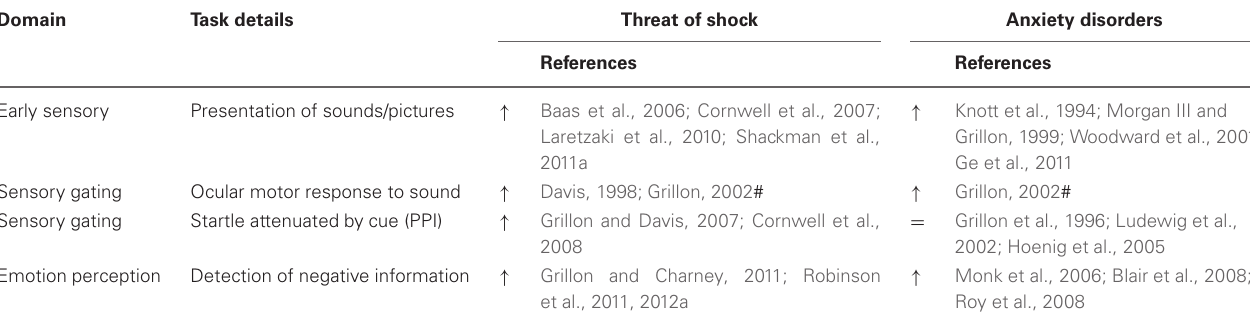
Table 2 | Effects of anxiety on sensory-perceptual processing (arrows represent direction of effect).